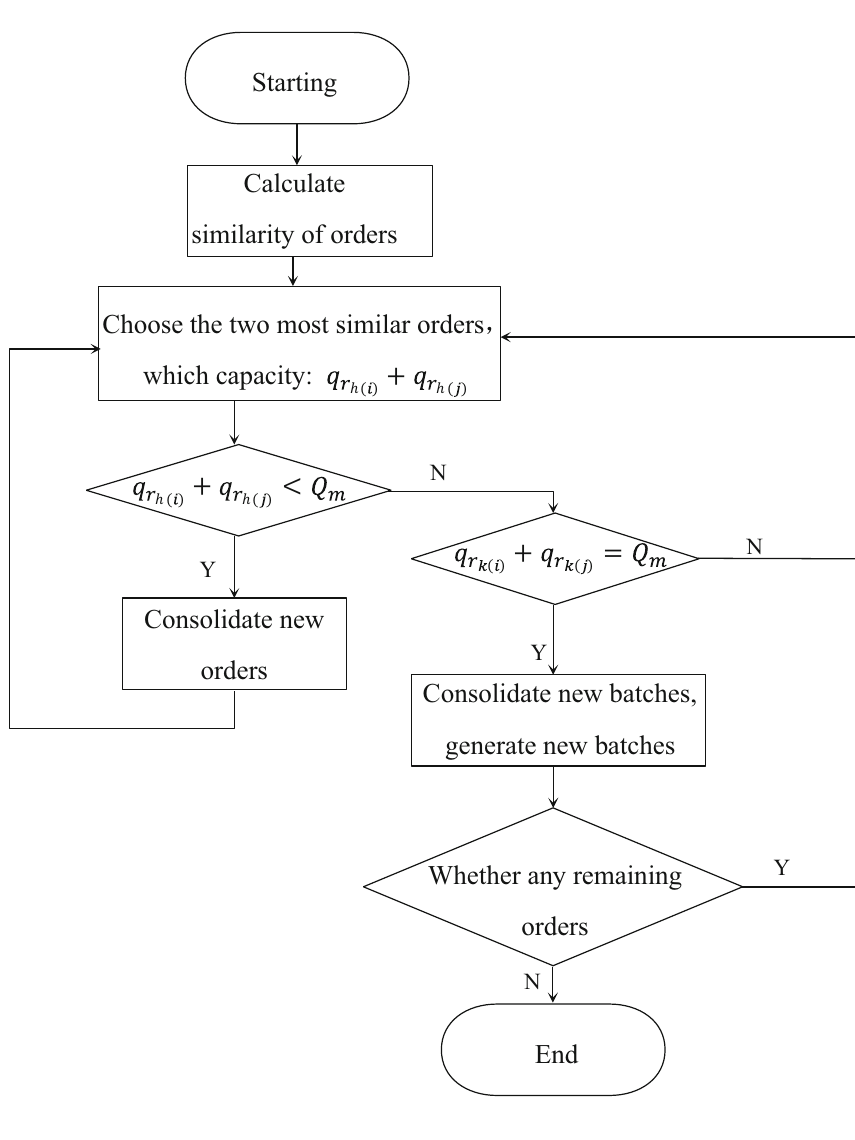
Fig. 3 Flow chart of order batching